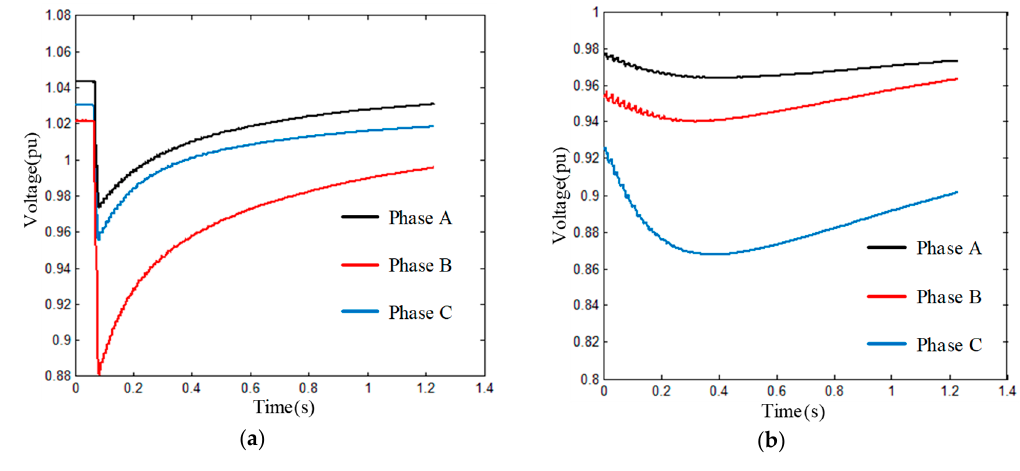
Figure 2. ( a ) Transformer energizing, ( b ) Motor starting.